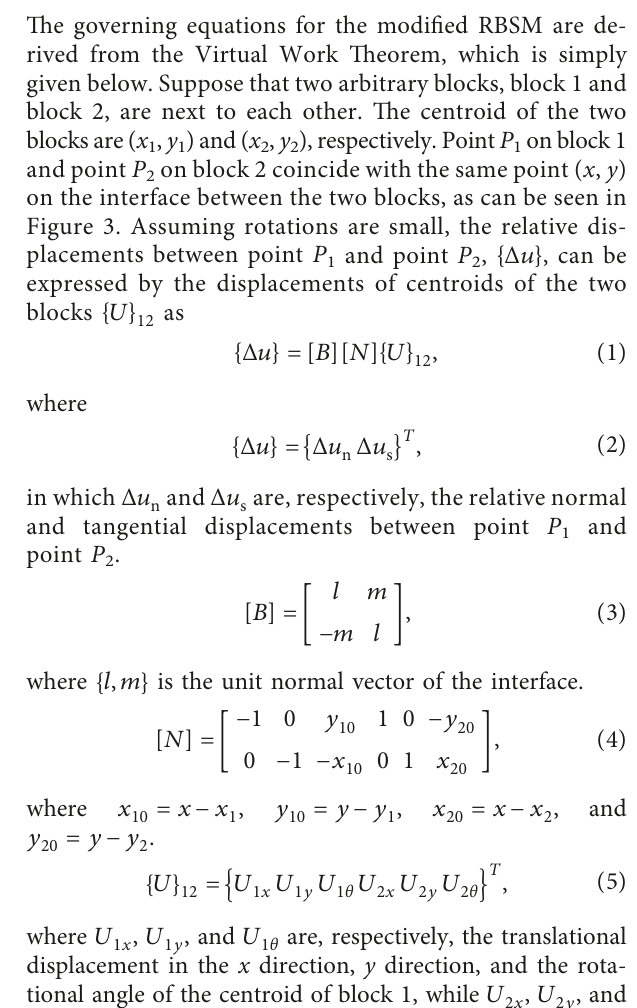
Figure 1: Definition of structural plane